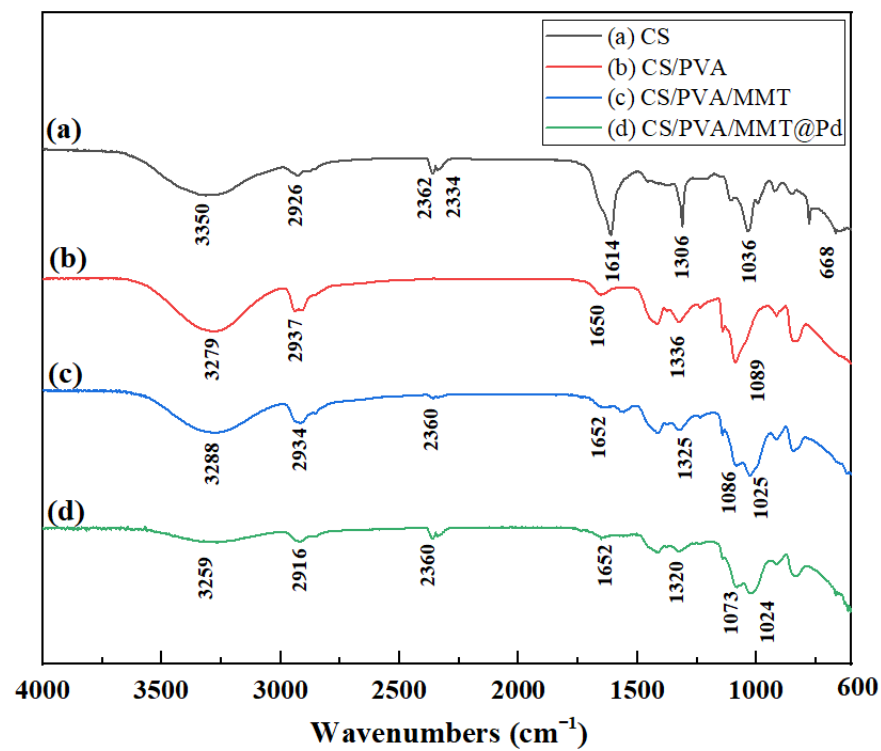
Figure 4. FTIR spectra of different films: ( a ) CS, ( b ) CS/PVA, ( c ) CS/PVA/MMT, ( d ) CS/PVA/MMT